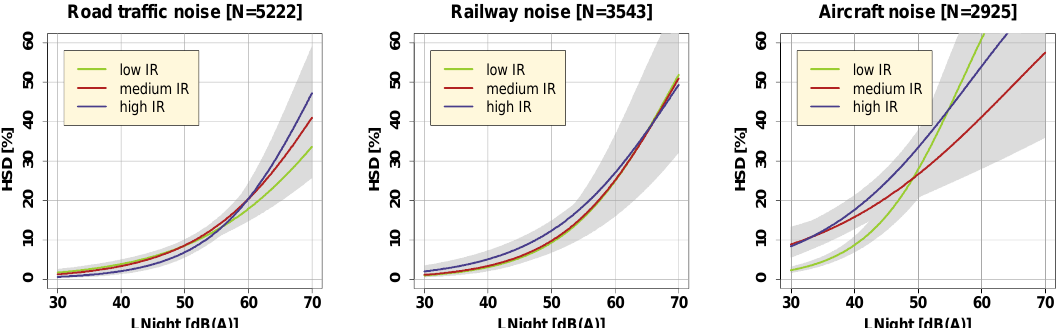
Figure 4. Exposure-response relationships for road traffic (left), railway (middle), and aircraft noise (right) in the full sample for three different IRNight categories, including 95% (overlapping) confidence intervals (shaded areas). Curves are based on the adjusted model in the full sample with covariates centered on the mean.